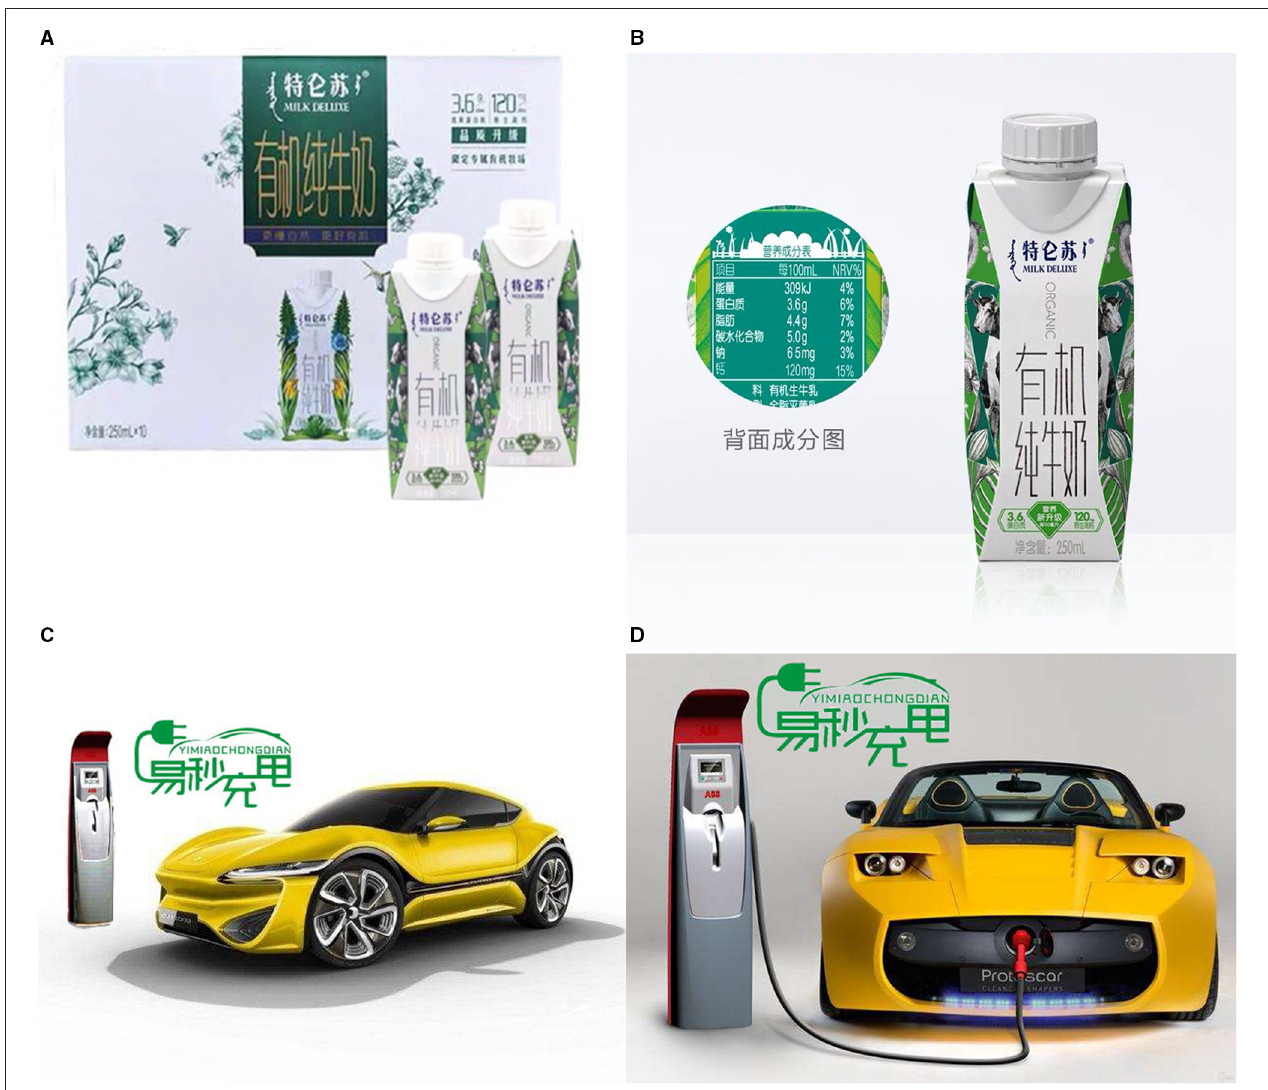
FIGURE 2 | Organic milk used with full-length shot (A) and close-up shot (B) ; New energy vehicles used with full-length shot (C) and close-up shot (D) (Image source: